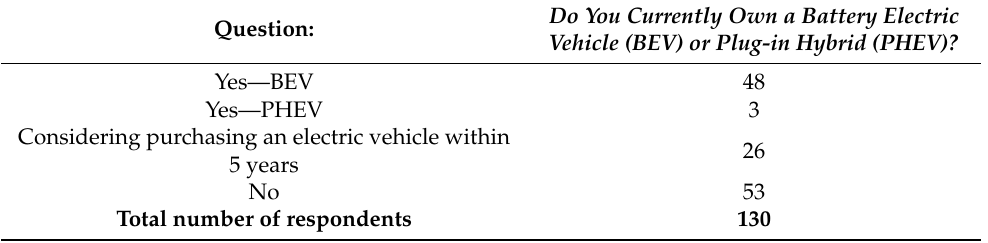
Figure A2. Responses to question (4). Table A4. Detailed responses to question (6).